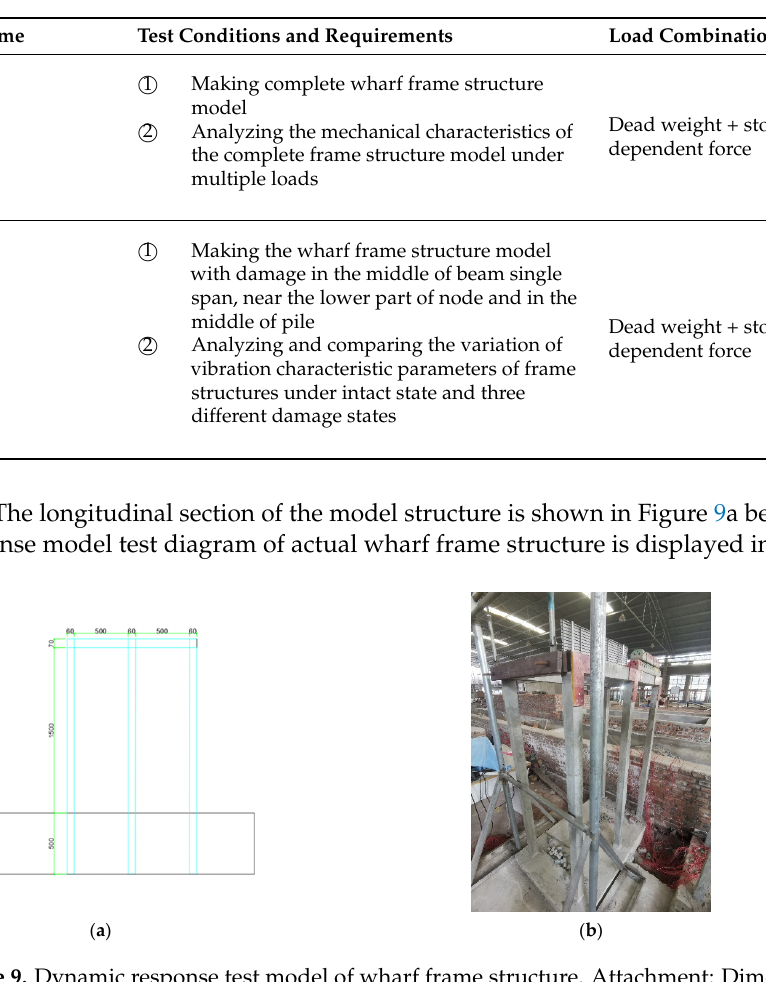
Table 2. Dynamic response test scheme of wharf frame model.